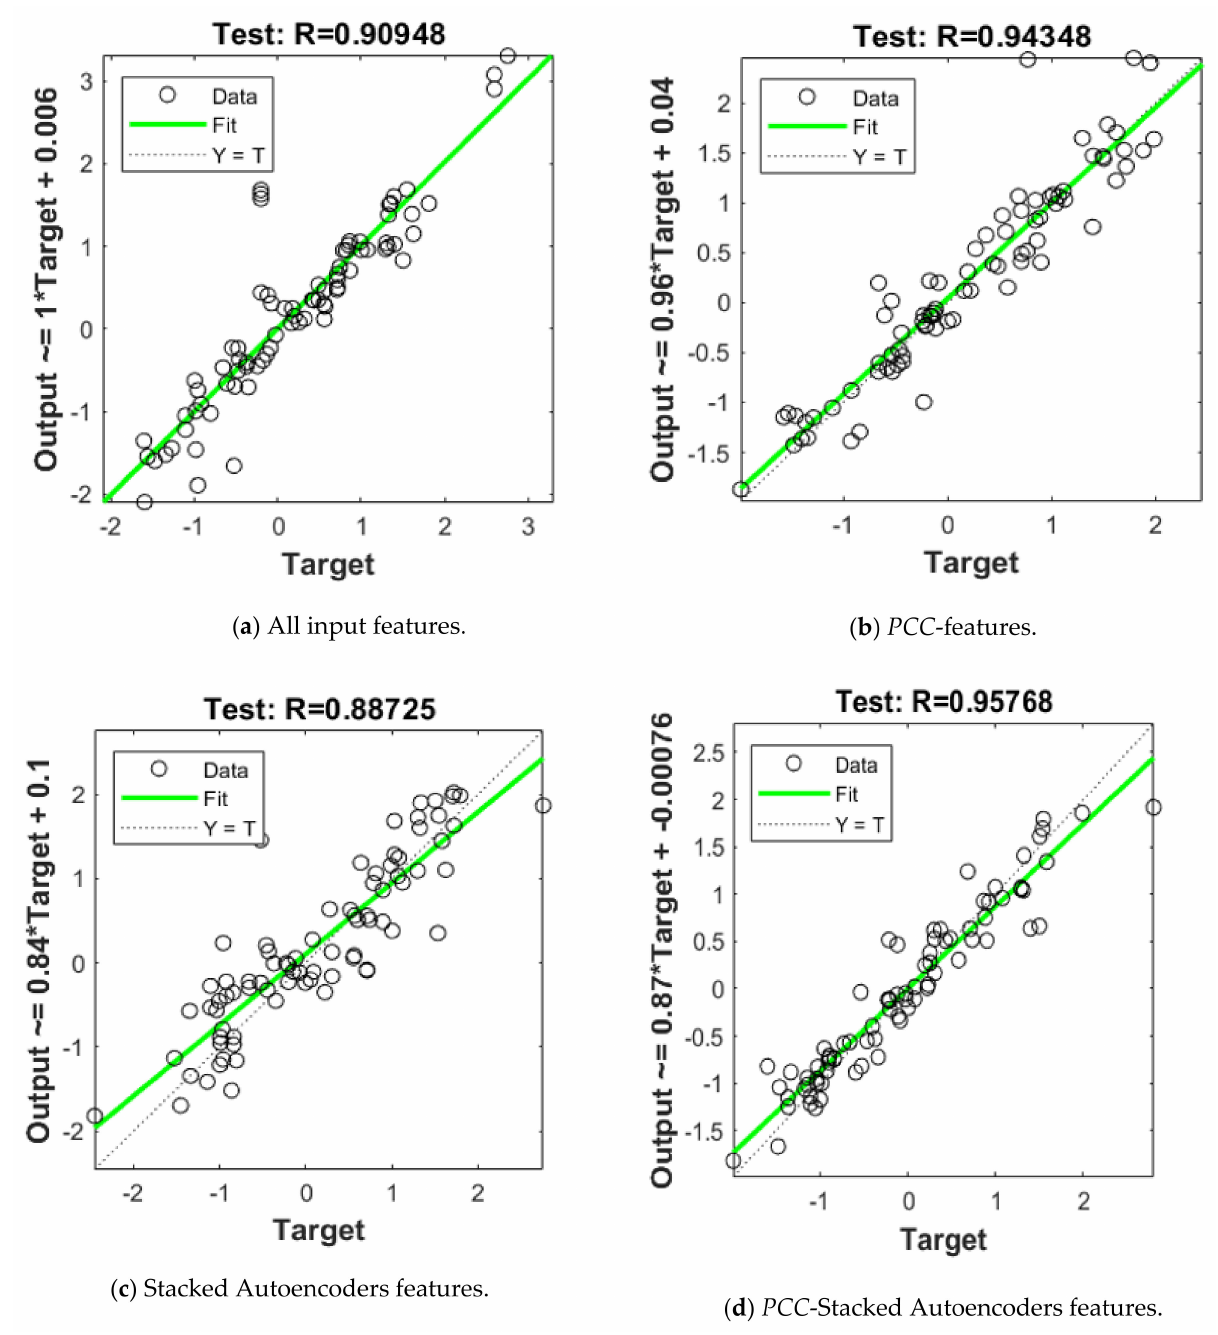
Figure 8. The fitting curves of the NN regression models trained using different sets of features for Gold